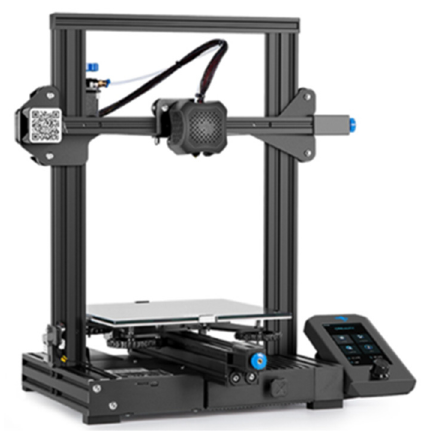
Figure 2. Creality Ender 3 V2 FDM